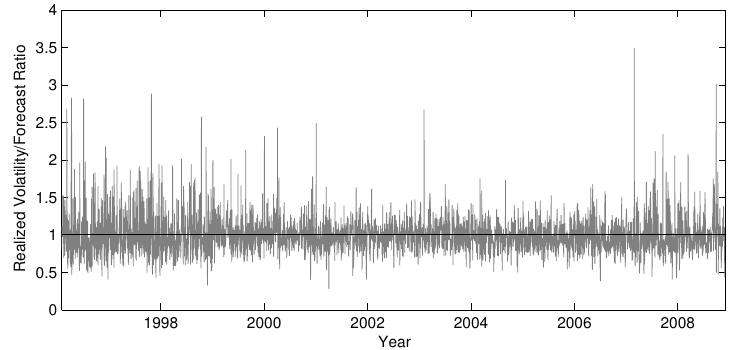
Figure 3. In-sample percentage errors for the HAR (heterogeneous autoregressive) model with leverage